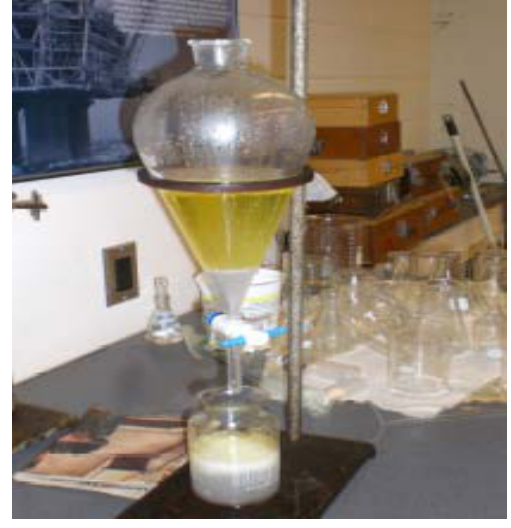
Figure 8. Biodiesel washing using distilled